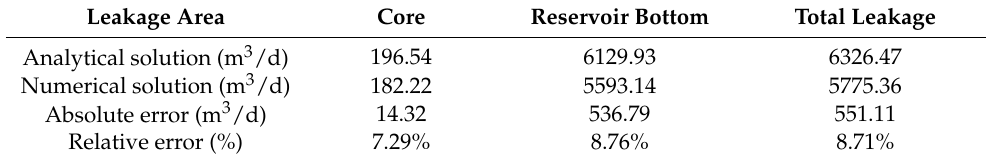
Figure 23. Piezometric contours and water table in the sub-base (x = 1018 m). clay core dam are presented in Table 7. Table 7. Leakage results calculated by both analytical and numerical methods.